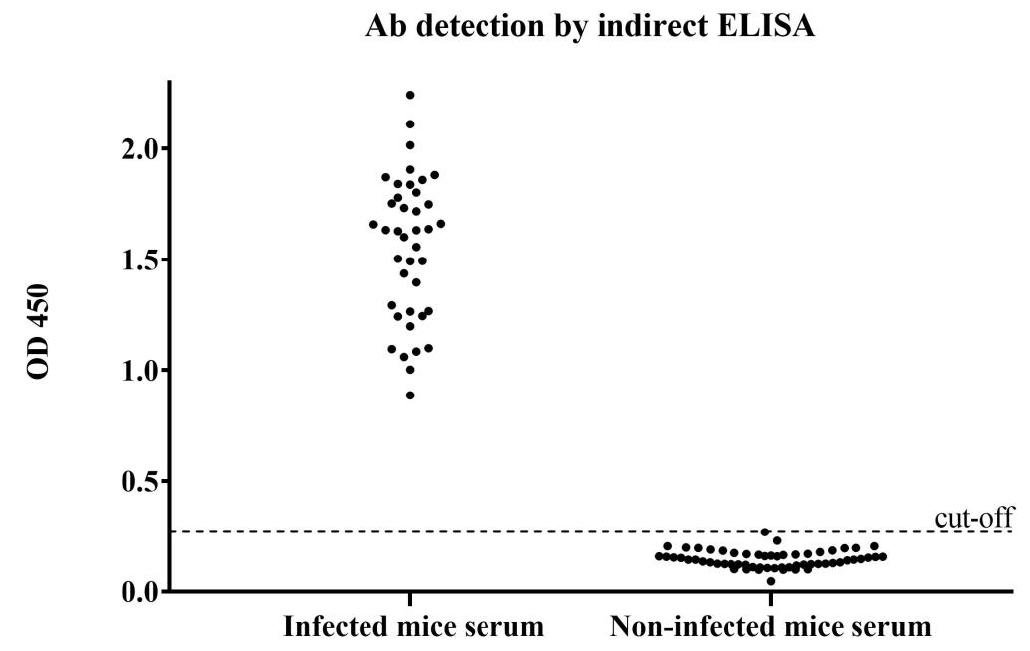
Figure 4. Detection of anti-rFgCathL1H antibody in the sera of mice. Mice were infected with F. gigantica ( n = 40), and non-infected mouse serum ( n = 60) was classified as positive and negative by indirect ELISA assay.